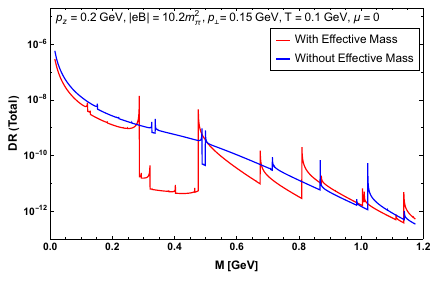
Figure 7. The comparison of rates calculated using basic thermal field theory and in the ambit of an e ff ective model (NJL).